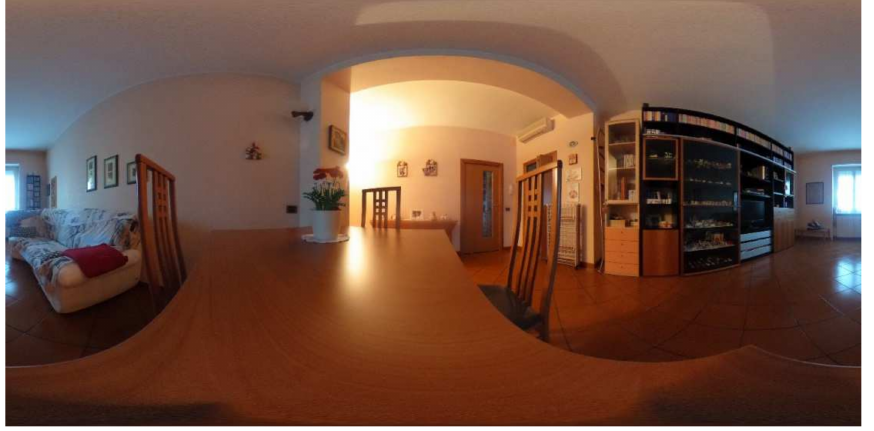
Figure 3. Example of neutral 360 ◦ environment that represents a living